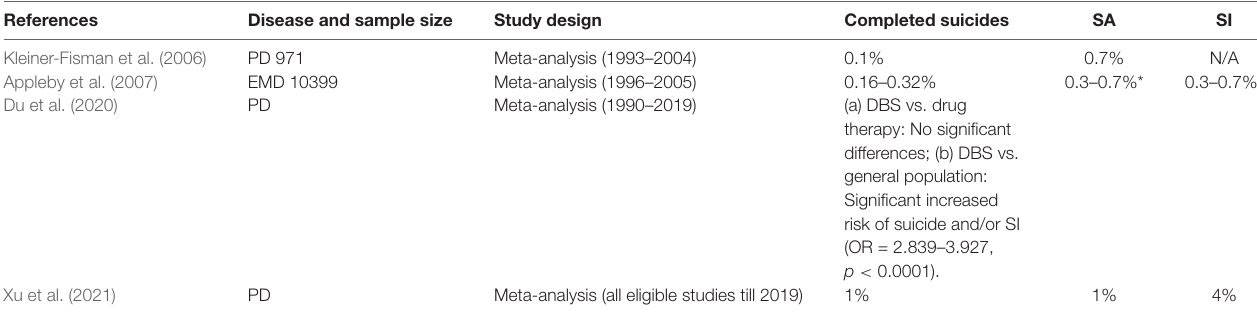
TABLE 2 | Meta-analysis on suicidality in patients who underwent DBS.